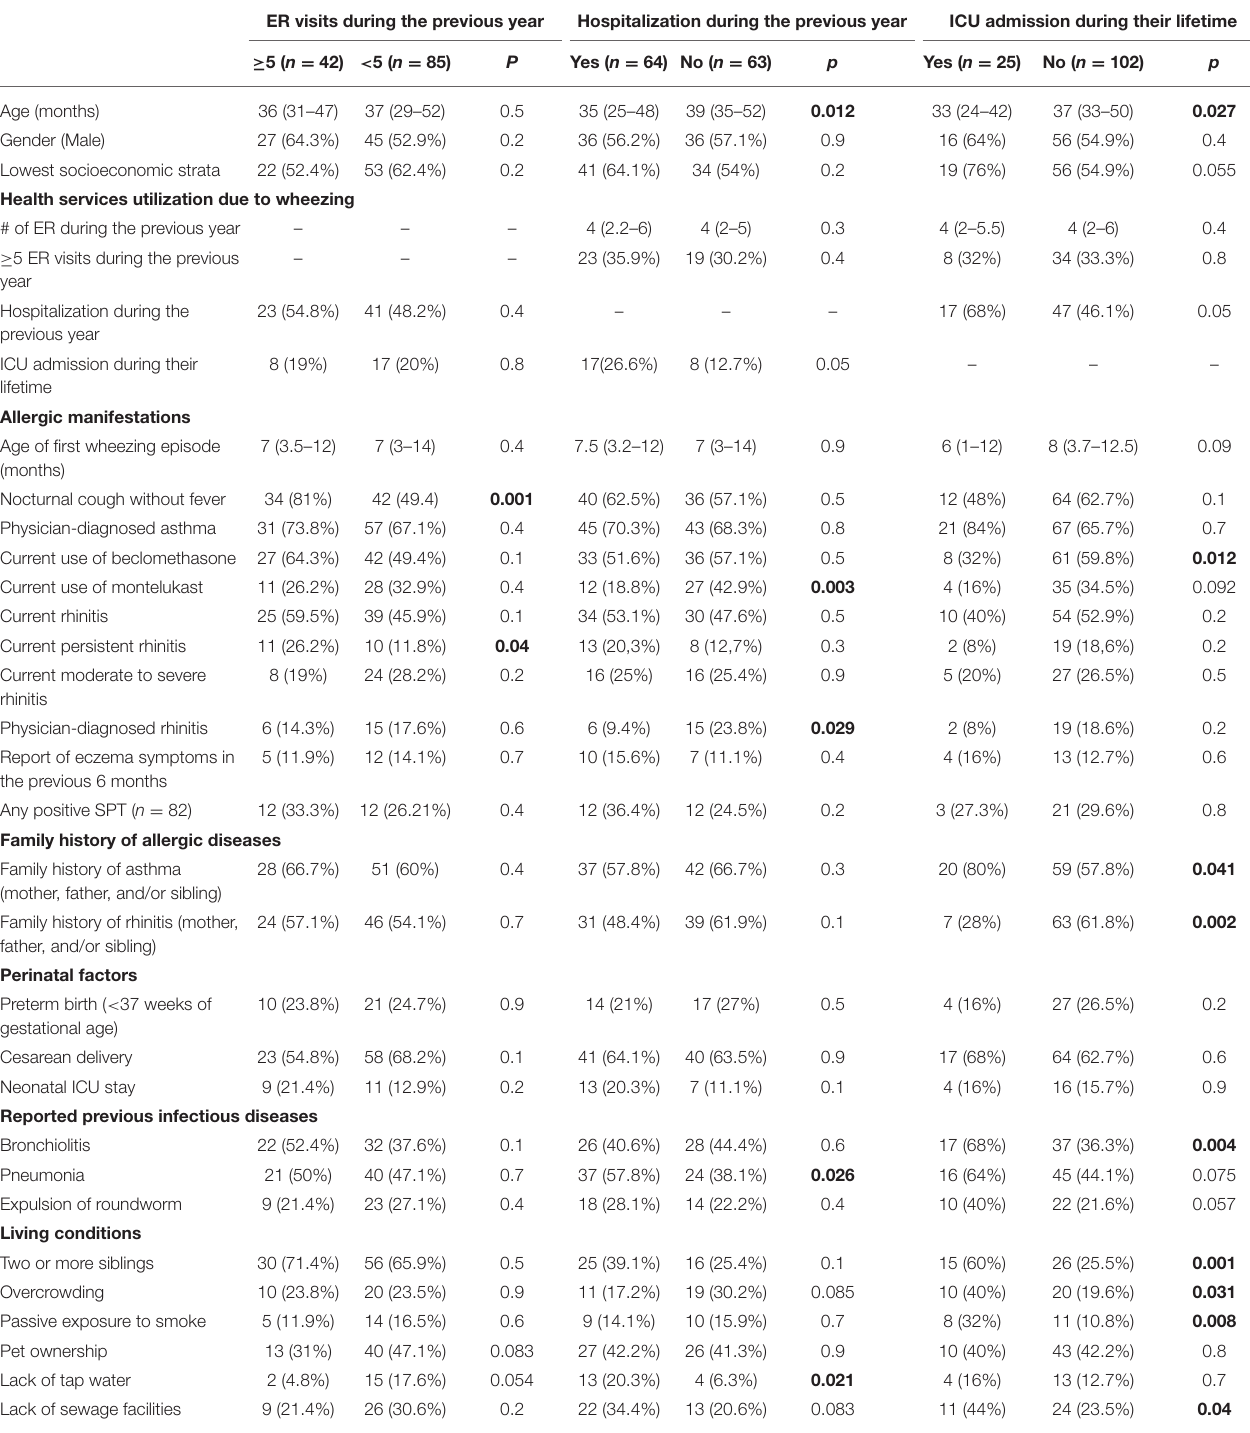
TABLE 2 | Distribution of variables according health services utilization in preschool